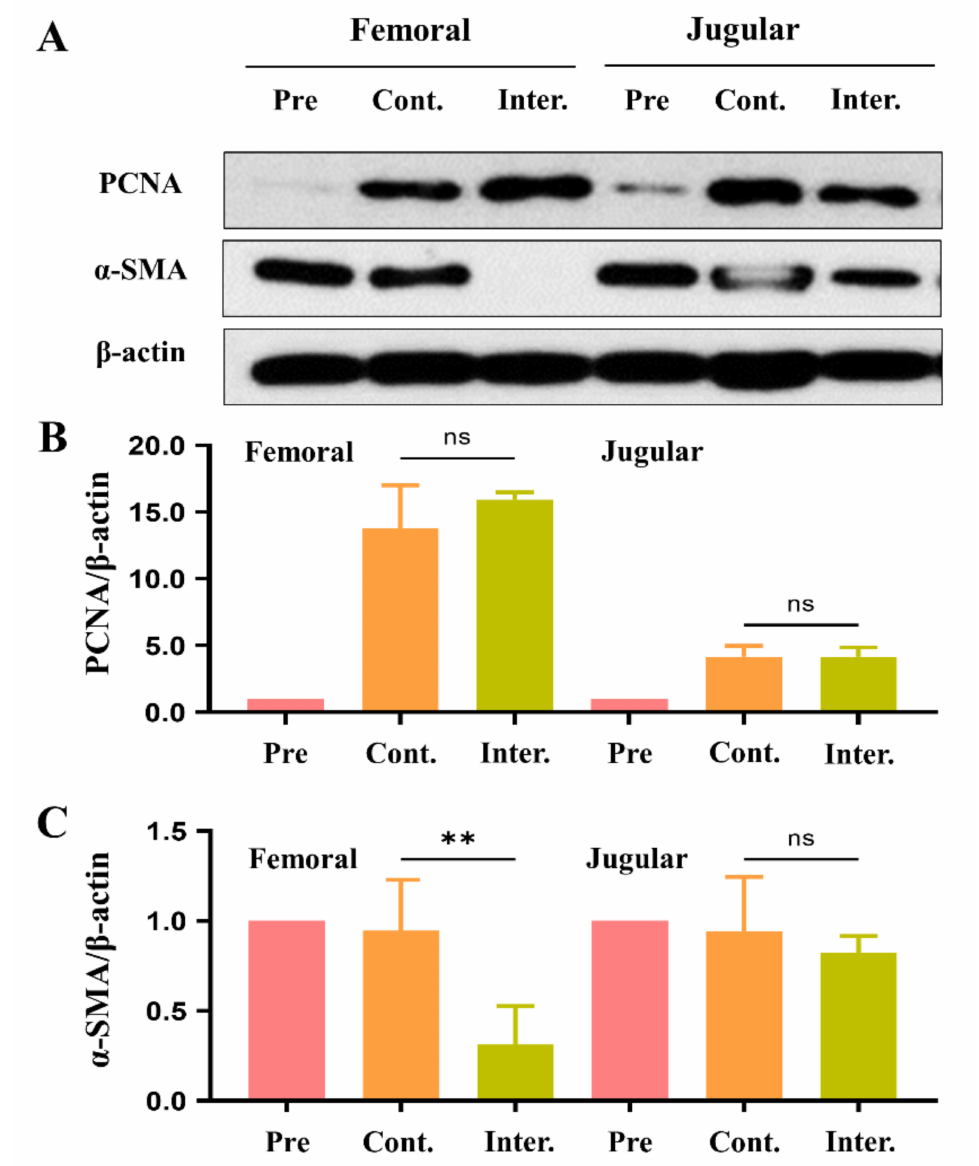
Figure 5. PCNA and α -SMA expression related to smooth muscle cell proliferation and differentiation. ( A ) Western blot analysis of PCNA, α -SMA, and β -actin and ( B , C ) quantitative analysis of ( B ) PCNA and ( C ) α -SMA expression of implanted vein grafts at preimplantation and in control and intervention groups (** p < 0.01; ns, p >